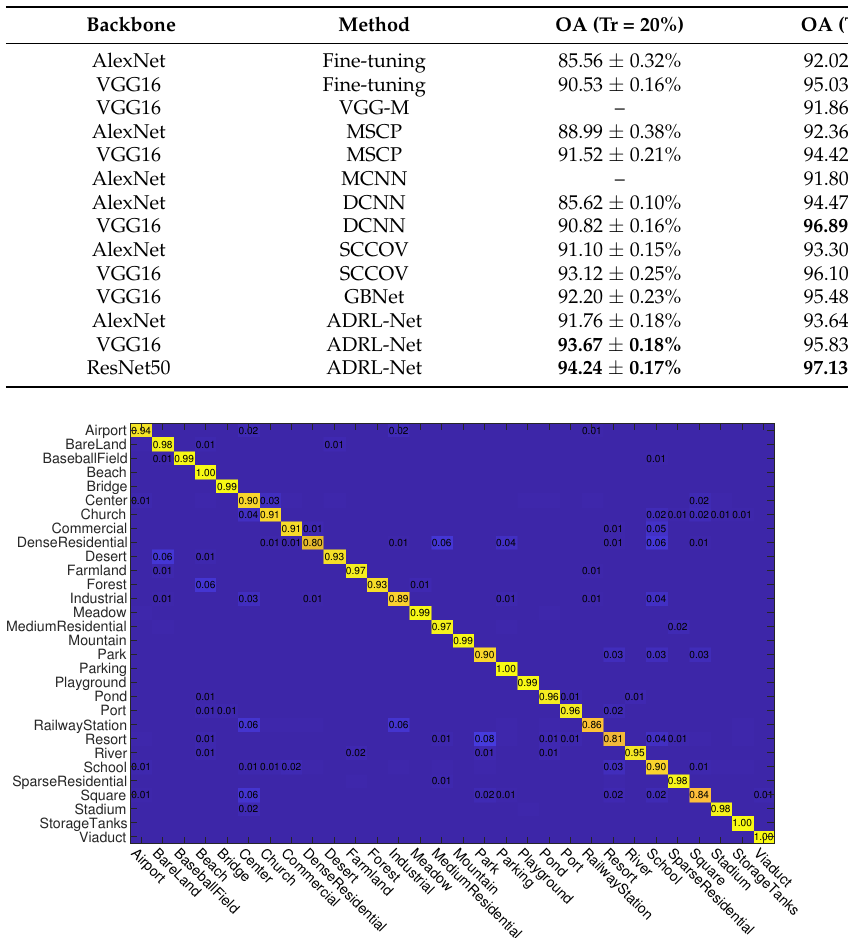
Figure 4. Confusion matrices obtained by ADRL-Net with ResNet50 as backbone on AID dataset. Tr =